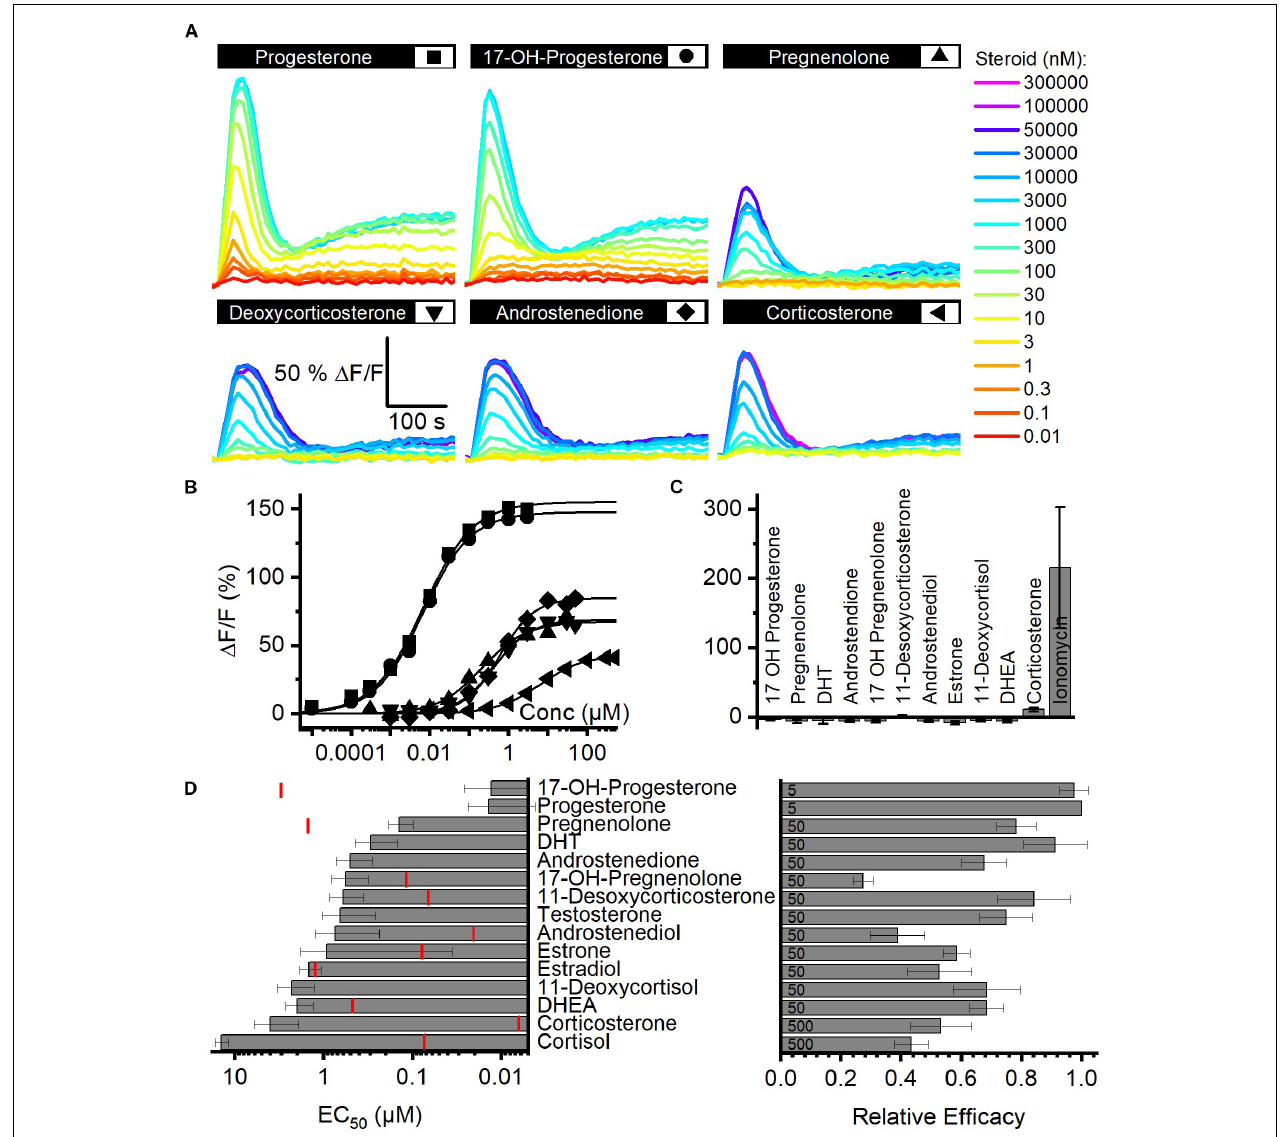
FIGURE 2 | Steroid-evoked Ca 2 + signals in human sperm. (A) Representative Ca 2 + signals evoked by progesterone, 17-OH-progesterone, pregnenolone, deoxycorticosterone, corticosterone, or androstenedione in control sperm from donors. (B) Concentration–response relationship for the maximal amplitudes of signals shown in (A) . (C) Mean ( ± SD) maximal amplitude of Ca 2 + signals evoked by steroids [at the concentration indicated in (D) ; right panel] or the Ca 2 + -ionophore ionomycin (2 µ M) in CATSPER2 - / - sperm ( n = 3). (D) Left: potency, i.e., mean ( ± SD) EC 50 ( n ≥ 4), of steroids to evoke Ca 2 + signals in control sperm (red lines indicate the concentration of the steroid in follicular fluid); right: relative efficacy of steroids to evoke Ca 2 + signals in control sperm, i.e., mean ( ± SD) maximal signal amplitude evoked by the respective steroid at the indicated saturating concentration (in µ M) relative to that evoked by progesterone (set to 1) ( n ≥ 5).